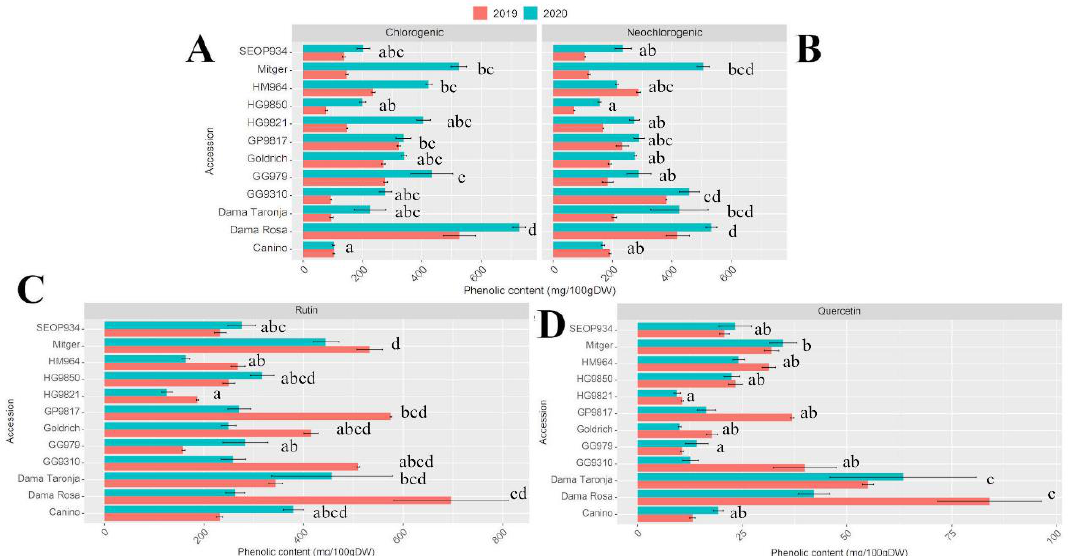
Figure 3. Chlorogenic ( A ), neochlorogenic ( B ), rutin ( C ) and quercetin-3-glucuronide ( D ) contents (mg/100 g DW) in 2019 (red) and 2020 (blue). Values represent the mean of 3 biological replicates, bars represent standard deviation. Different letters represent statistical differences between genotypes.